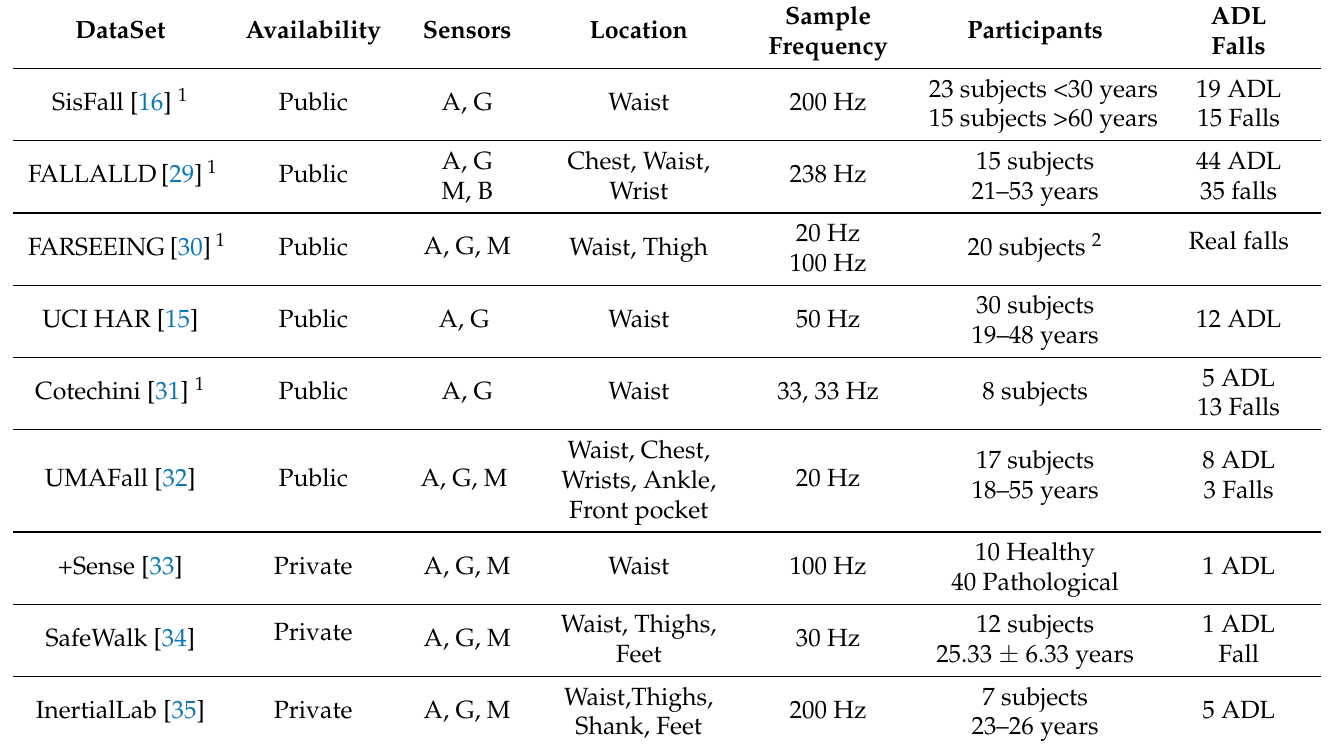
Table 2. datasets description regarding sensing methods and location, sample frequency, participants and activities recorded, where: A = Accelerometer, G = Gyroscope, M = Magnetometer, B = Barometer and ADL = Activities of Daily